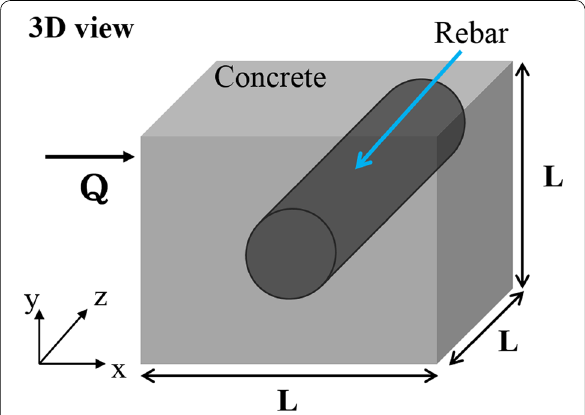
Fig. 1 Schematic of reinforced concrete containing one round rebar.